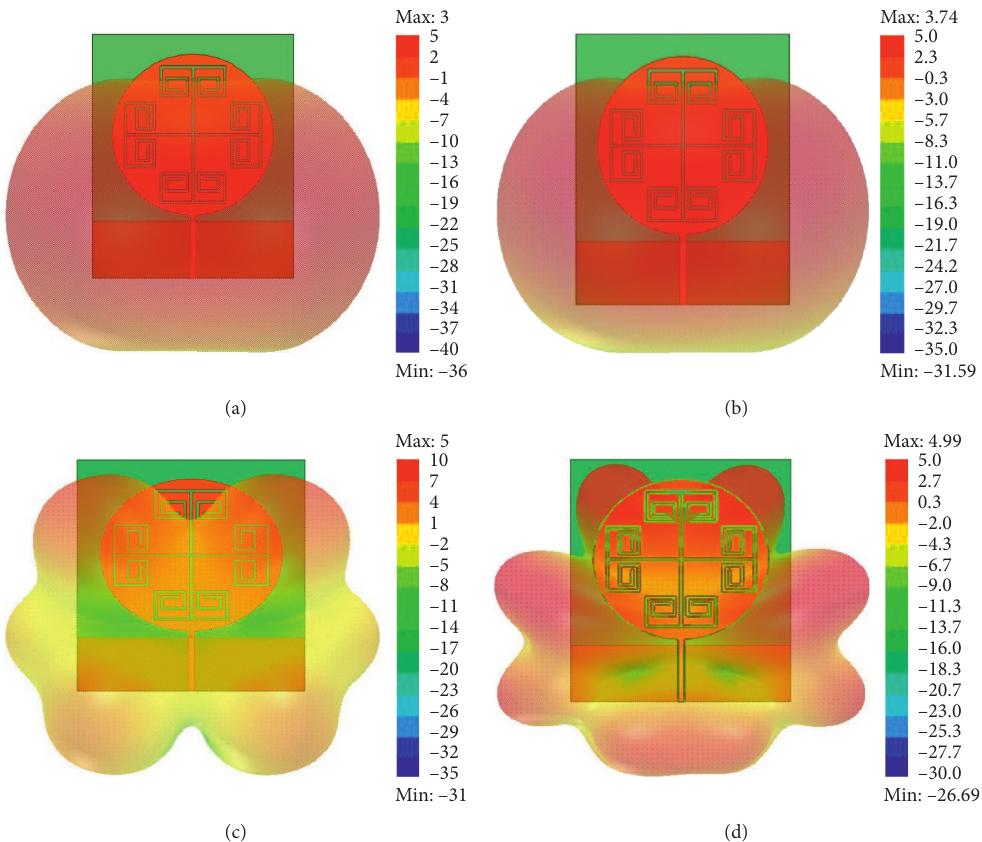
Figure 10: 3D radiation patterns at (a) 1.6GHz, (b) 2.35GHz, (c) 3.8GHz, and (d) 5.85